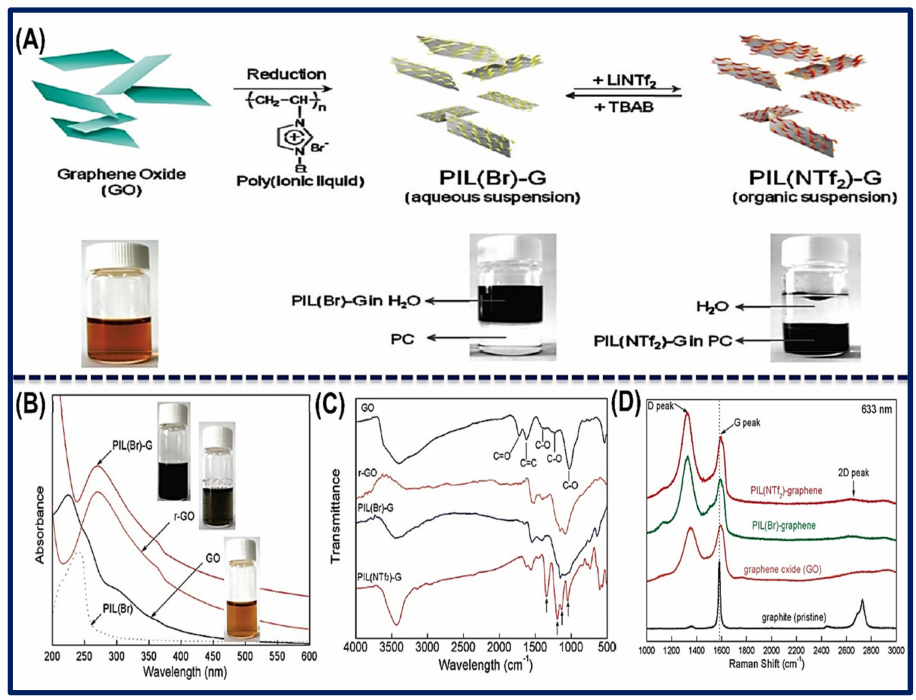
Figure 3. ( A ) Schematic illustration of the synthetic process of the (PIL)-G sheet and anion exchange of PIL, leading to the phase transfer of PIL-modified GR sheets between aqueous and organic solvent media. ( B ) UV-vis spectra and ( C ) FT-IR spectra of GO, RGO, an aqueous suspension of PIL(Br)-G, and an organic phase suspension of PIL(NTf 2 − )-G. ( D ) Raman spectra of pristine graphite, GO, PIL(Br)-G, and PIL(NTf 2 − )-G. Reprinted with permission from Ref. [68]. Copyright 2010, American Chemical